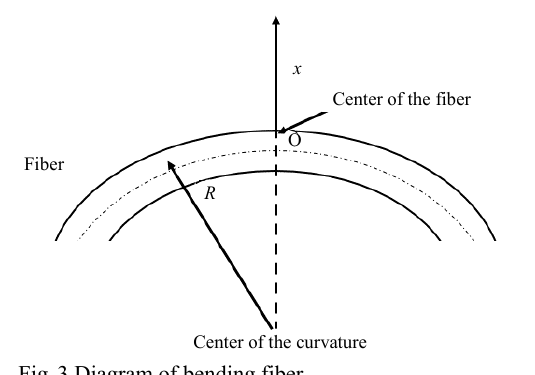
Fig. 3 Diagram of bending fiber.